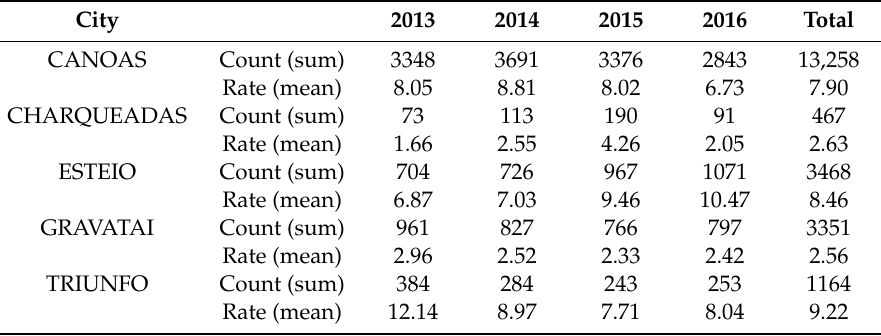
Table 1. Total counts and mean of monthly rates of hospitalizations per 100,000 inhabitants by year and municipality, Rio Grande do Sul State, Brazil